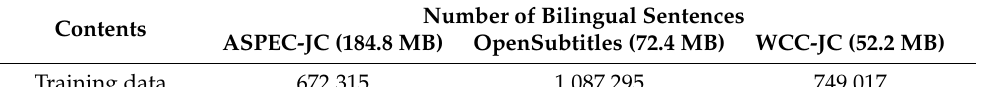
Table 2. Japanese-Chinese bilingual